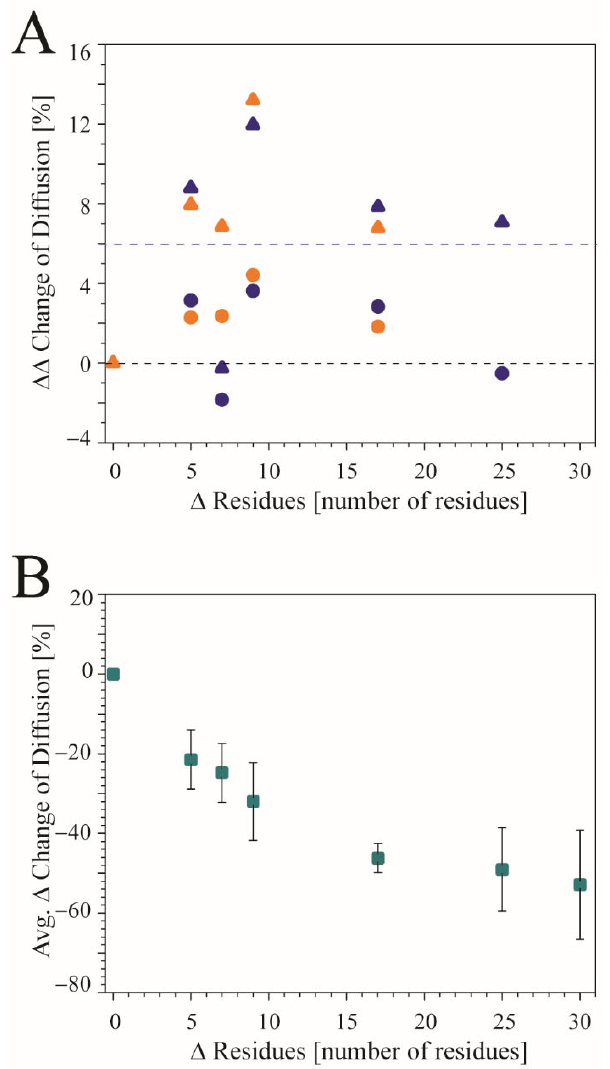
Figure 4. ( A ) The percentage change ( ∆∆ change) of the diffusion coefficients (DCs) between spp and lpp between monomeric and oligomeric states using the monomeric state as reference [(oligomeric state (lpp–spp))–(monomeric state (lpp–spp))]. The ∆∆ changes of DCs that are bigger than zero indicate that the decrease is larger between spp and lpp in the monomeric state than in the oligomeric state. Numbers smaller than zero indicate that the DCs decrease more between spp and lpp in the oligomeric state. The data do not discriminate between fusion and ion channel proteins. The blue and orange circles refer to the translational DCs taken from simulations of the experimental and ideal structures, respectively. The triangles refer to the respective rotational DCs (blue for experimental structures and orange for ideal structures). ( B ) Data of the differences in the DCs from the same amino acid number difference, ∆ Residues, between two protocols, (lpp–spp) are averaged over all translational and rotational DCs independent of the type of peptide and oligomeric state.